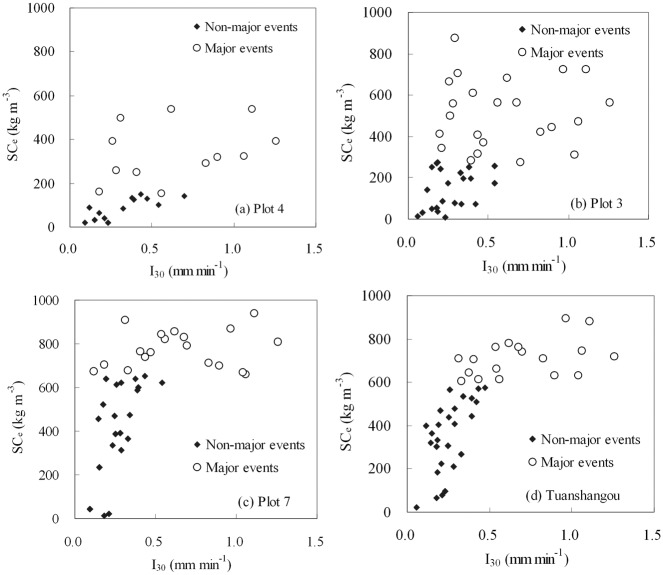
The relationship between I
30 and SC
e for the Tuanshangou station (#3) and three experimental runoff plots within it.